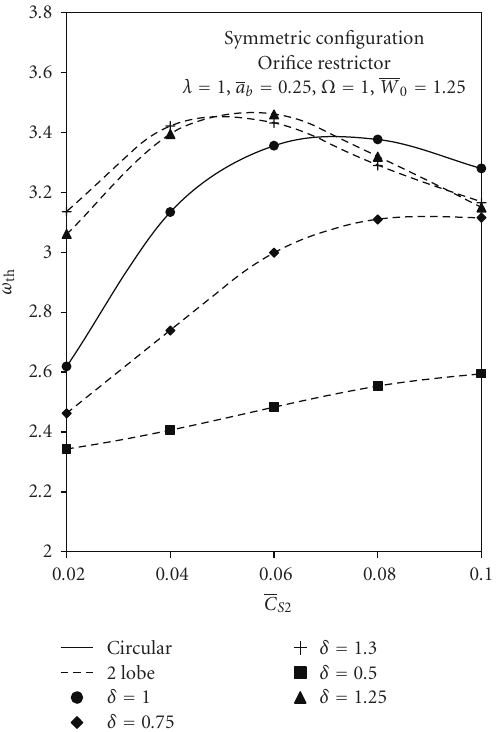
Figure 14: Variation of threshold speed ( (cid:11) th